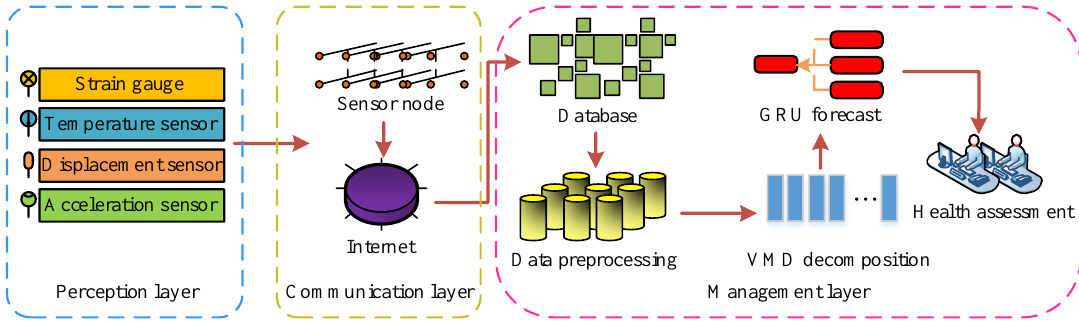
Figure 5. WSN civil structure SHM prediction model structure integrated with VMD-GRU.